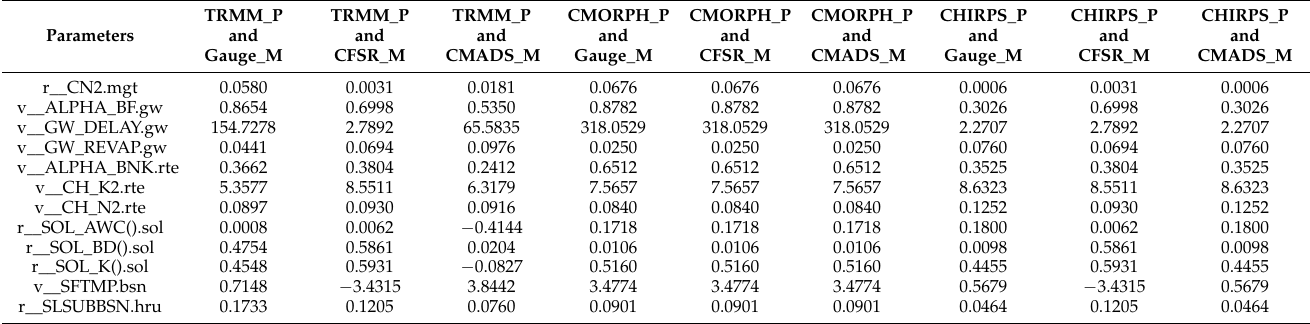
Table 5. Optimal parameters calibrated for the scenarios using the TRMM, CMORPH, and CHIRPS precipitation data. The scenarios using the same precipitation data and different meteorological (excluding precipitation) data often had similar optimal parameters (with the different ones displayed in bold). “Gauge_P” represents using gauged precipitation data, “Gauge_M” represents using gauged meteorological data, and so